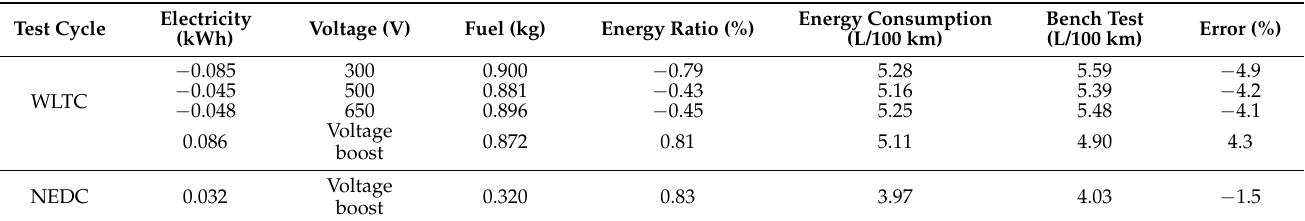
Table 4. Energy consumption performance of HEV